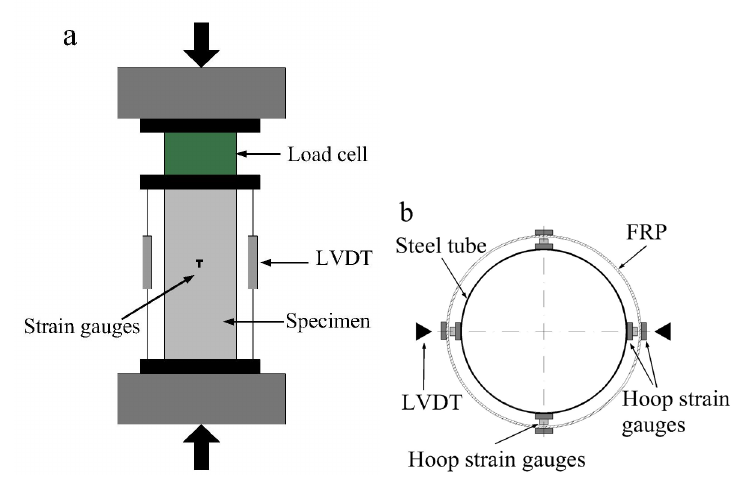
Figure 1. Test arrangement and instruments: ( a ) test arrangement; ( b ) layout of strain gauges for fiber-reinforced polymer (FRP)-confined concrete-filled steel tube